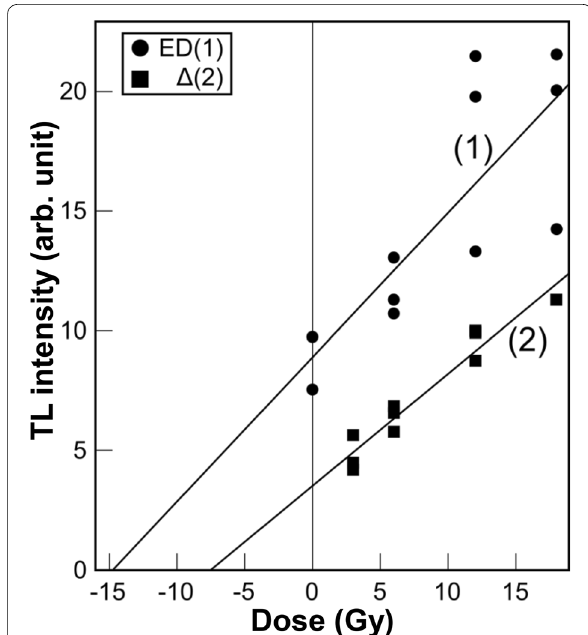
Fig. 2 TL growth curves for the equivalent dose (1) and nonlinear correction (2)